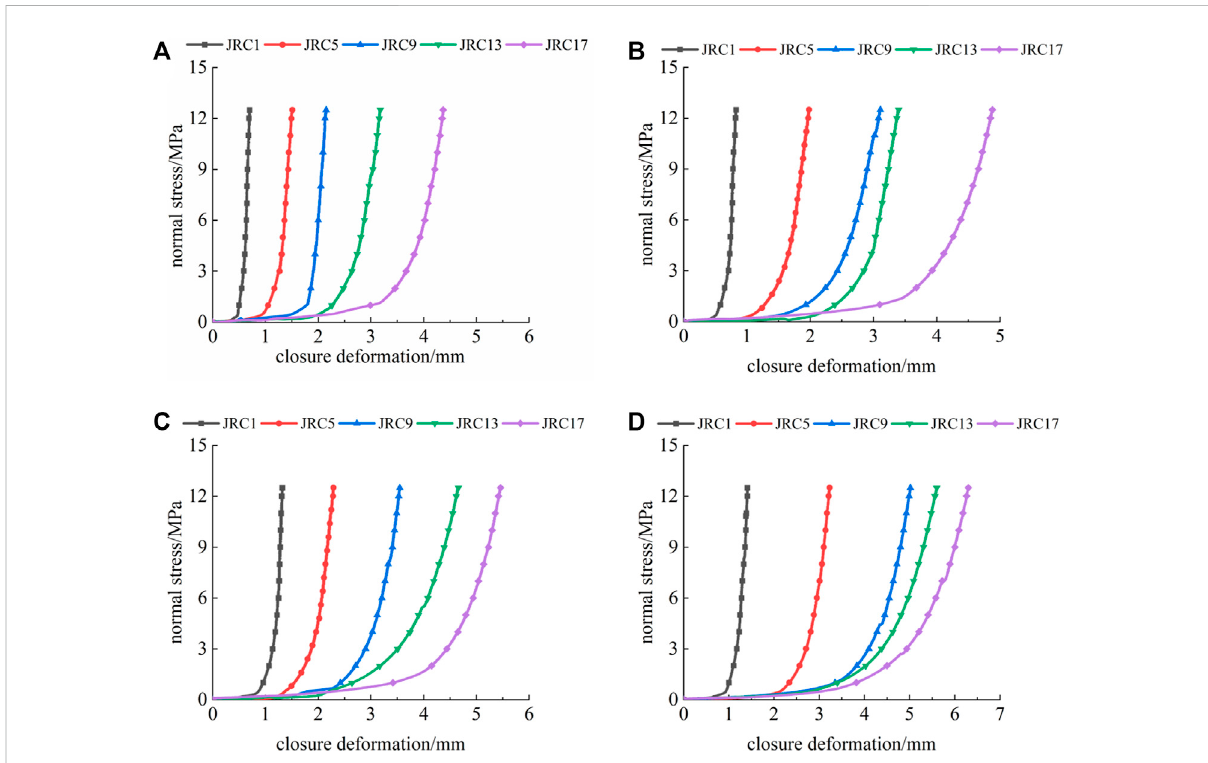
FIGURE 8 Normal stress-closure deformation curve of a fi lled rock joint under different degrees of fi lling: (A) k=0.5; (B) k=1.0; (C) k=1.5; and (D) k=2.